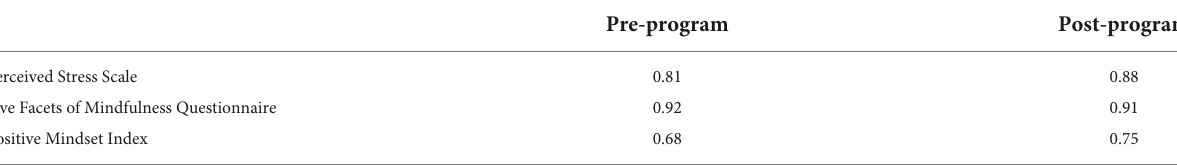
TABLE 4 Cronbach’s alpha—self-report measures (pre-program N = 28; post-program N =